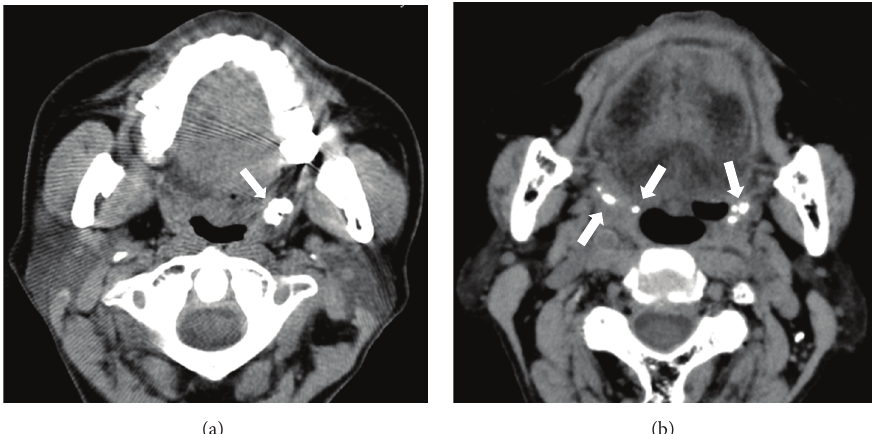
Figure 1: Axial CT images. (a) Single large tonsillolith in the left palatine tonsil (white arrow). (b) Multiple small tonsilloliths involving right and left palatine tonsils (white arrows).